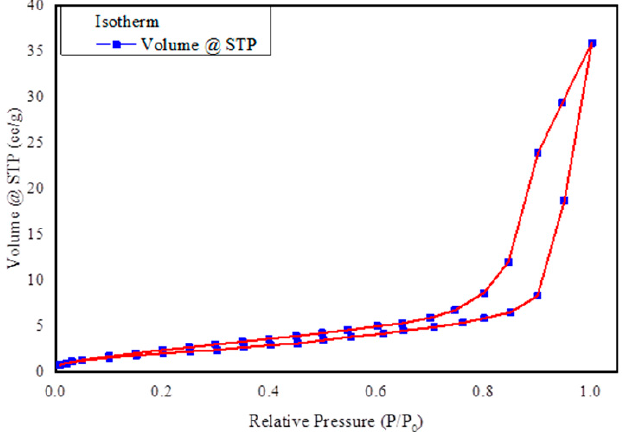
Figure 6. Low-temperature N 2 adsorption–desorption plot for ZnO@XG